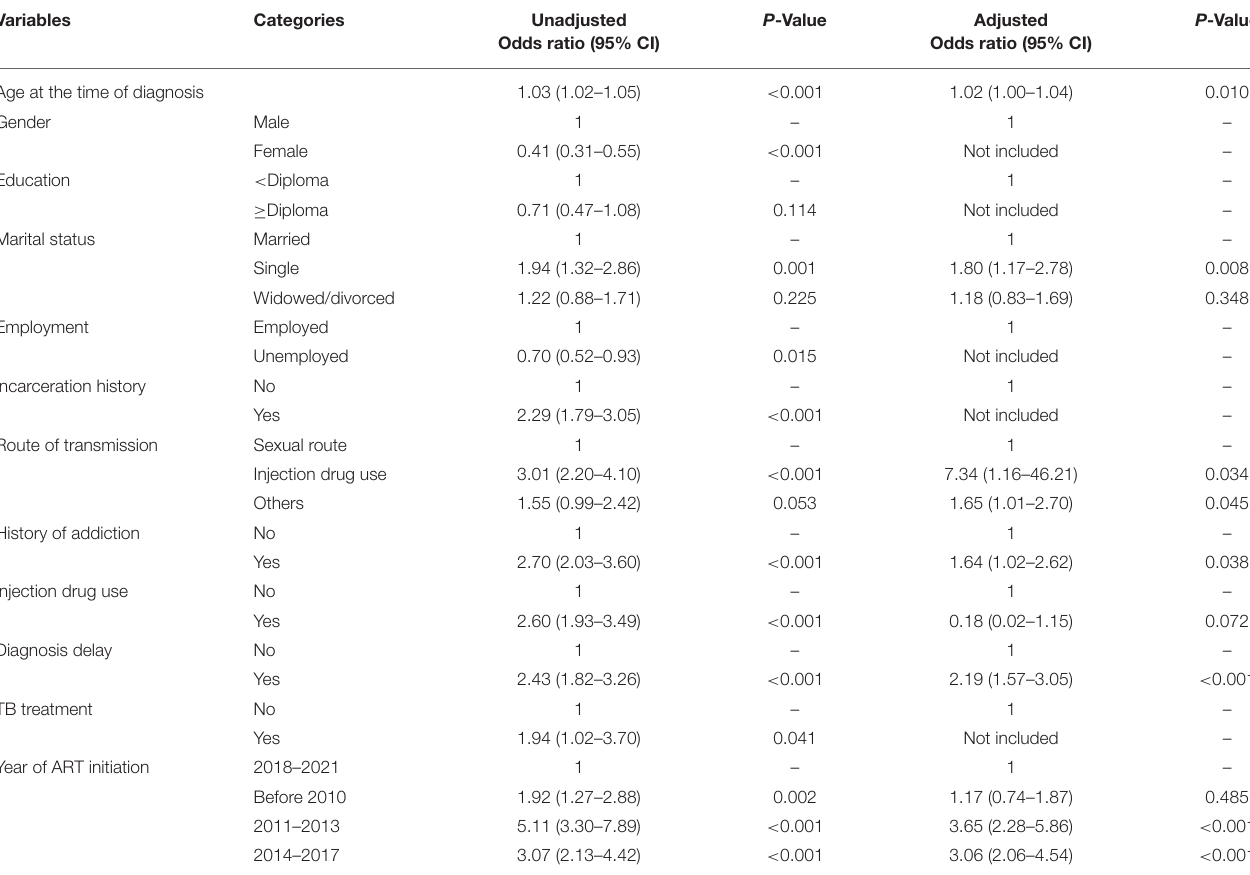
TABLE 2 | Adjusted association of study variables with late ART initiation